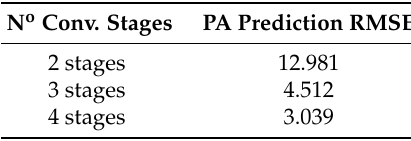
Table 4. Root mean square error (RMSE) with different number of convolutional